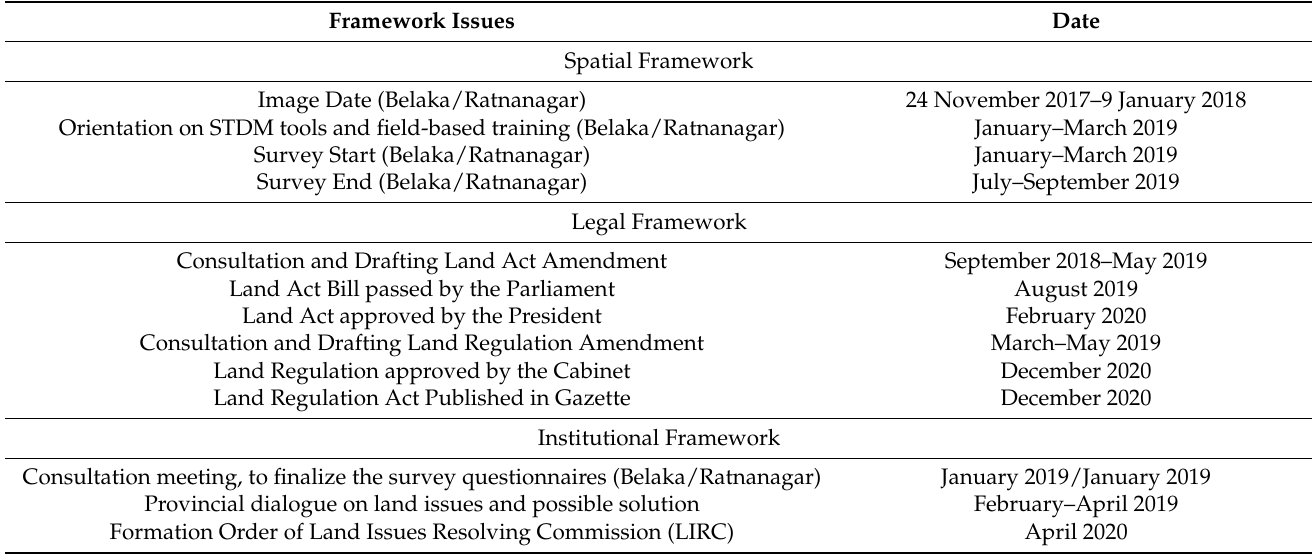
Table A1. Important Dates.